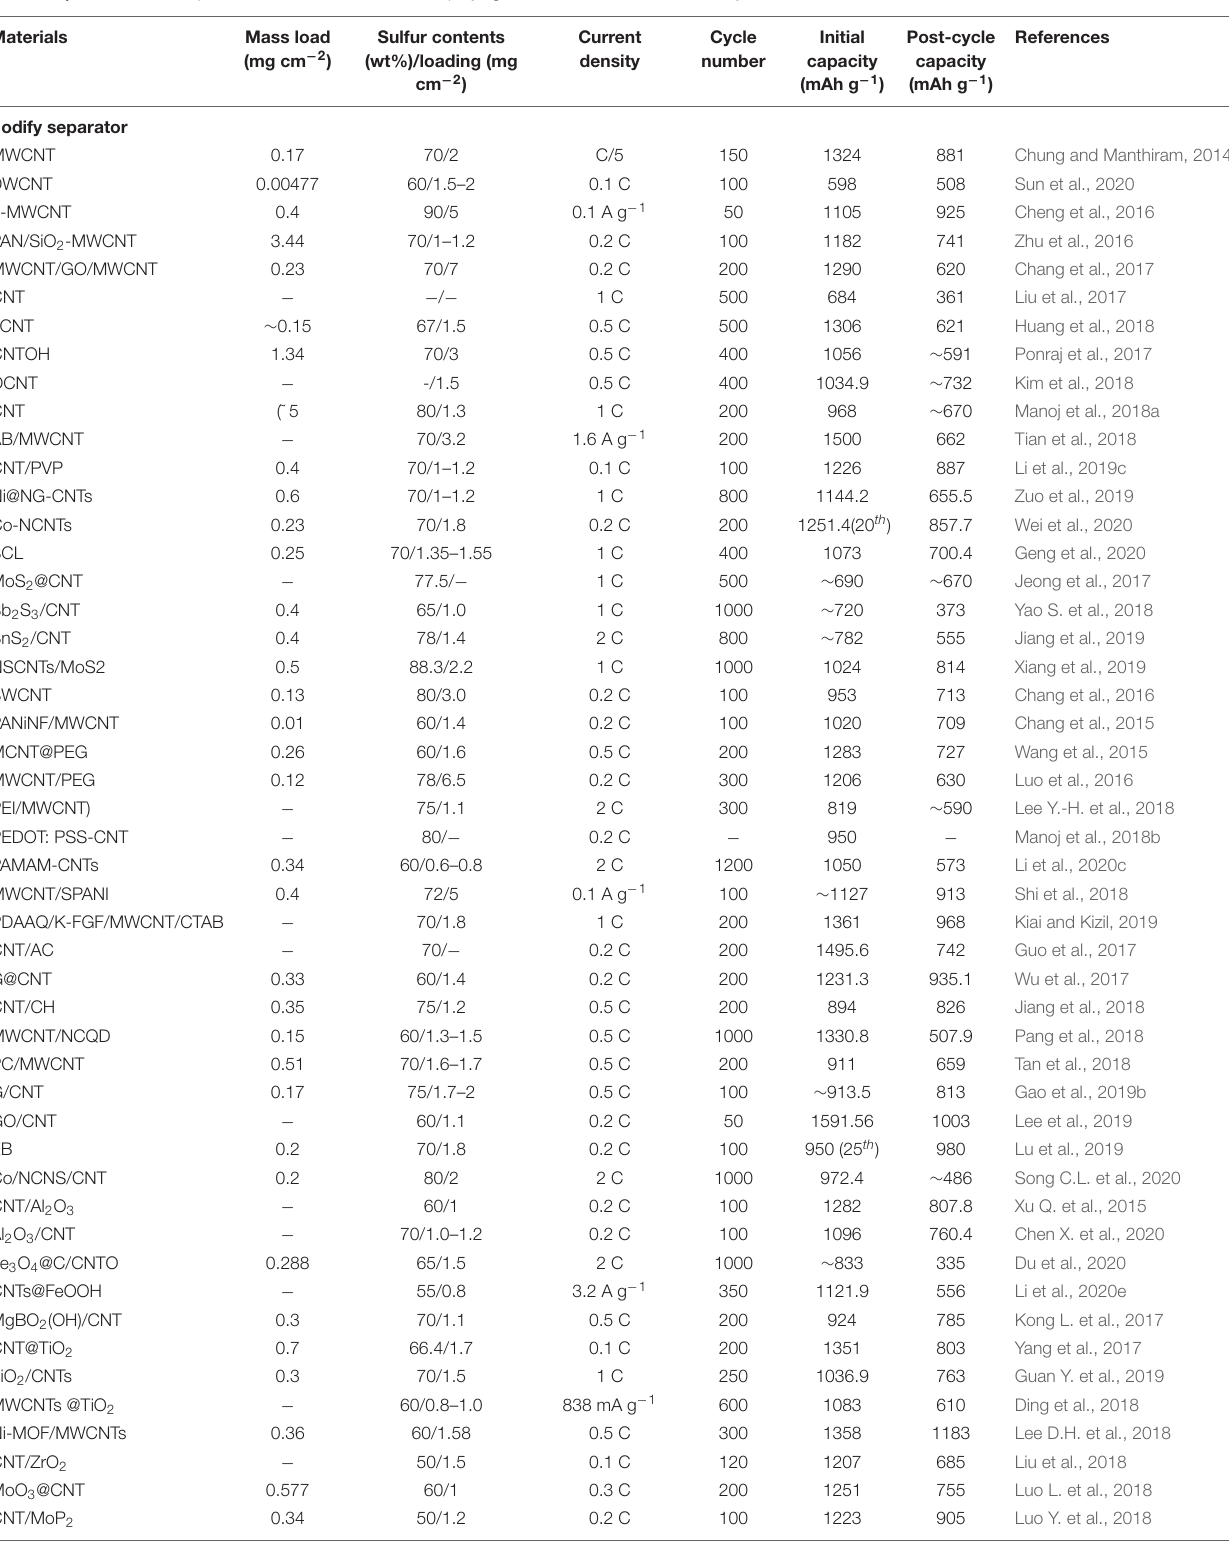
TABLE 1 | Electrochemical performance of Li–S batteries employing CNT-based materials as interlayer.